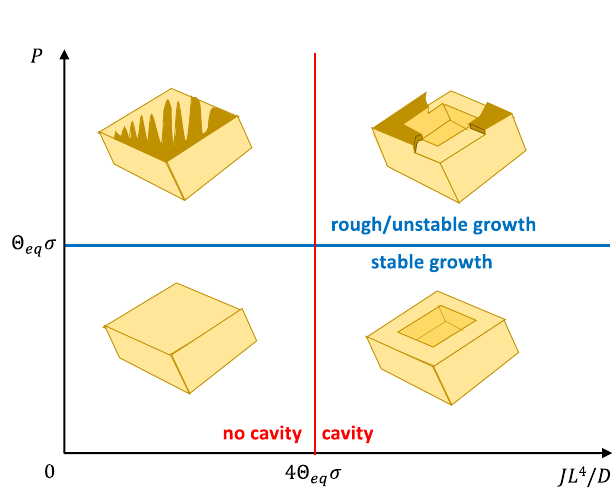
A – C Timelapseofthesamestepfrontat0.45sintervals. C – F Fourconsecutivestep fronts nucleated at opposite sides with a time delay of 54±7s. The black arrow indicatesthe direction fromwhichthe layeroriginates.The orientation-dependent growth kinetics of the respective layer is indicated by the white